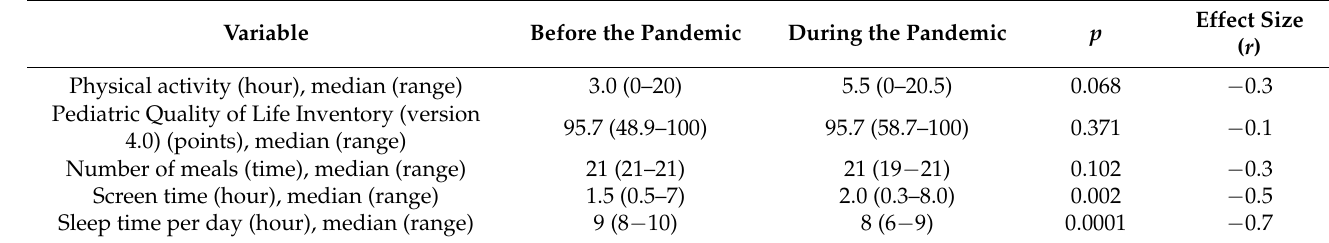
Table 3. Participants’ questionnaire scores before and during the COVID-19